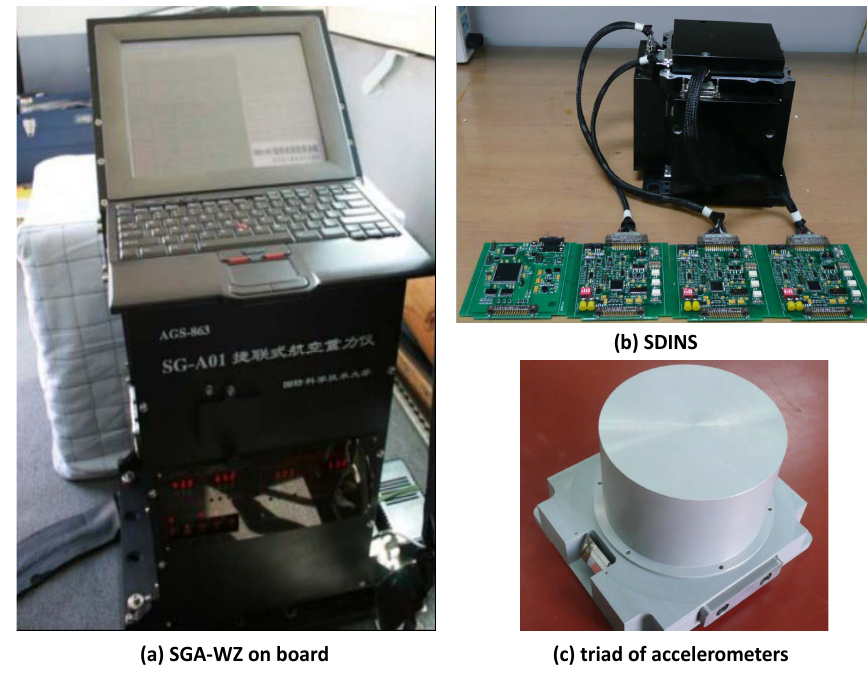
Figure 4. The SGA-WZ mounted on the aircraft and its primary components.